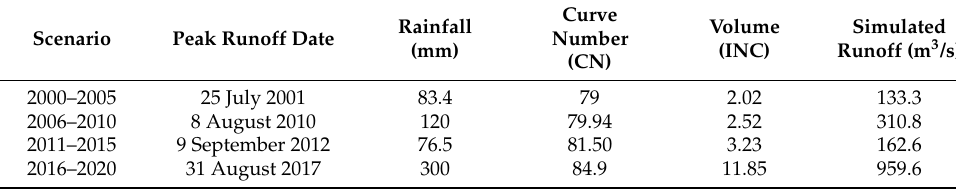
Table 4. Runoff generation for different climate/land-use